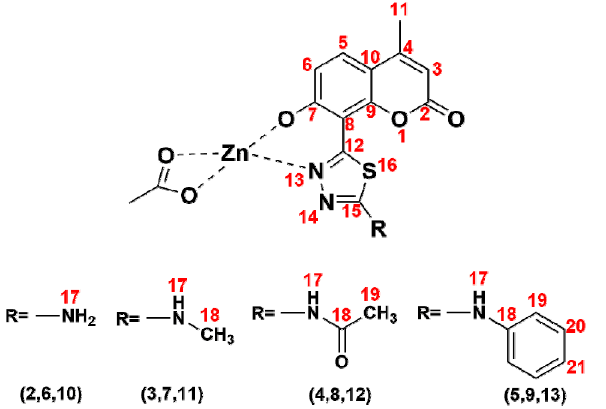
Figure 2. Structures of coumarin-thiadiazole hybrids and their corresponding Zn(II) complexes showing the numbering system of atoms.